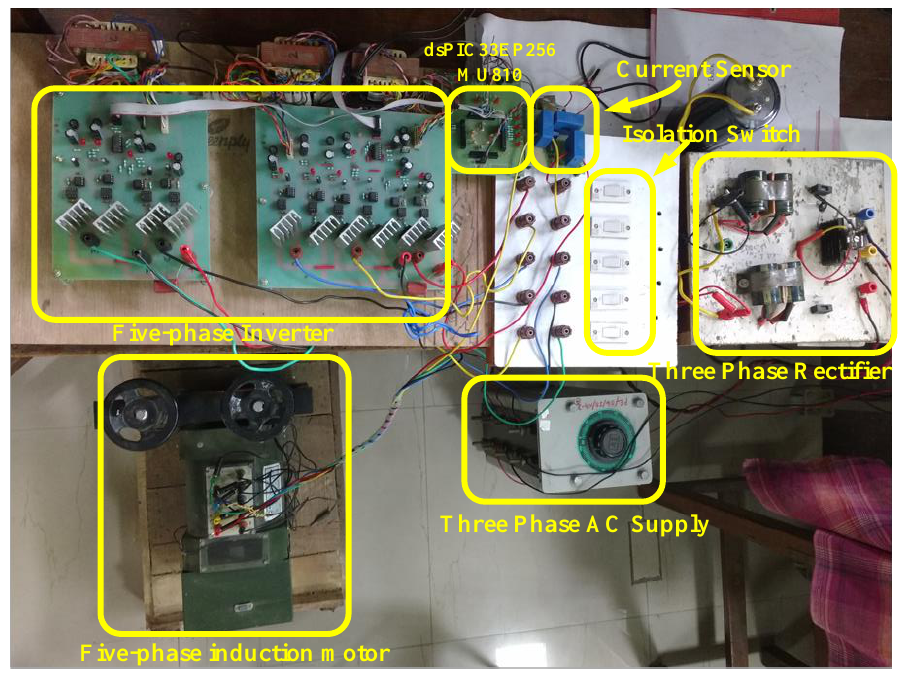
Figure 5. Experimental setup.